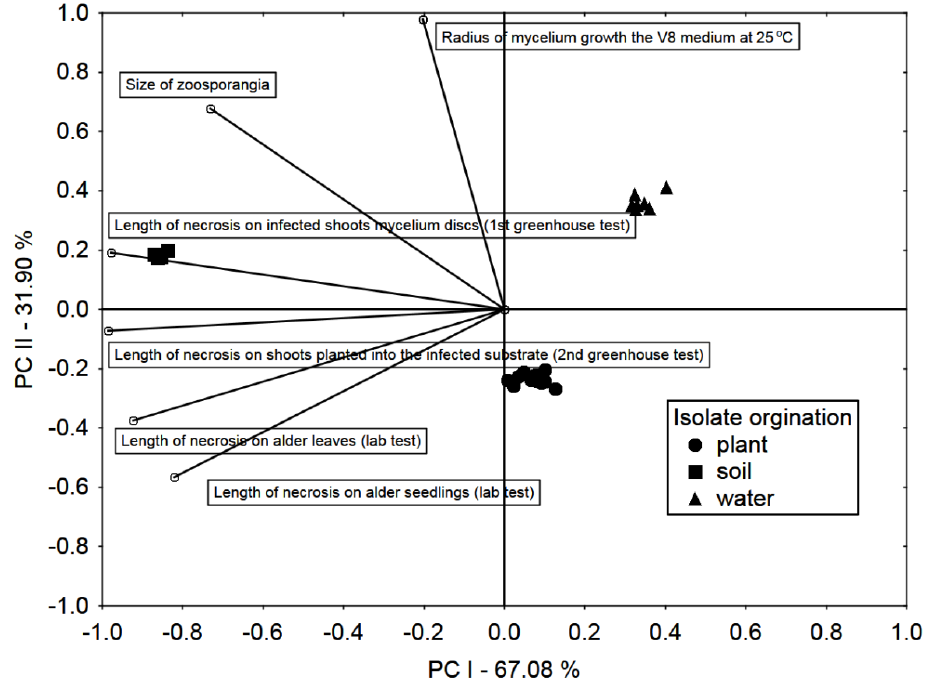
Figure 5. Principal Component analysis (PCA) biplot in the arrangement of the first two principal components PC I and PC II. Vectors and symbols representing, testing methods and isolate origin, respectively.